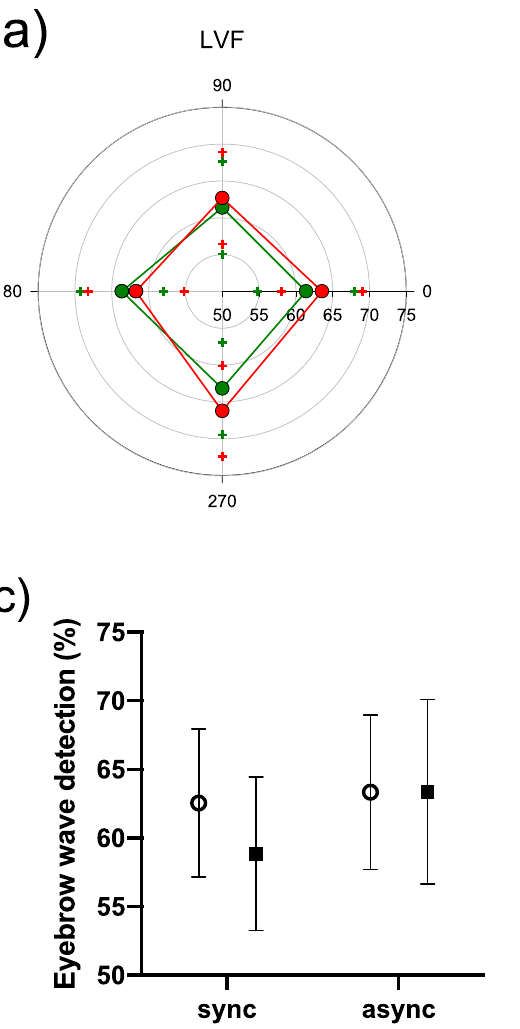
effect in Experiment 2 is driven by differences in adaptation. In Experiment 2, there was no inversion effect for synchronous tests, irrespective of the type of adaptation. There was however evidence for an inversion effect The reduced sensitivity to the eyebrow wave during synchronous facial motion, which was evident in all three experiments, is consistent with reduced access to features when features are grouped by higher order structure. For example static curved lines are more difficult to detect in a visual search task when these features are pre- sented in a schematic facial configuration, in which they depict mouths and eyebrows, as compared to when they are randomly located 25 and vernier acuity is impaired when lines are grouped with flanking lines 26 .The poorer detection of feature motion (the eyebrow wave) in the case of synchronous motion indicates that eyebrows and